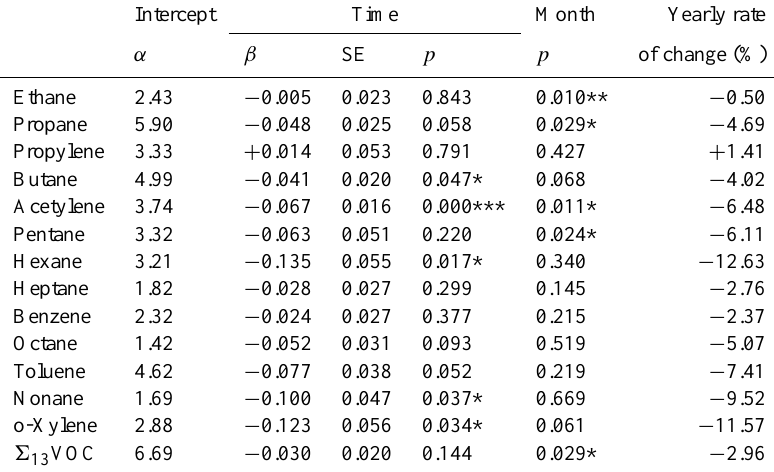
Table 2. Linear regression for all VOC